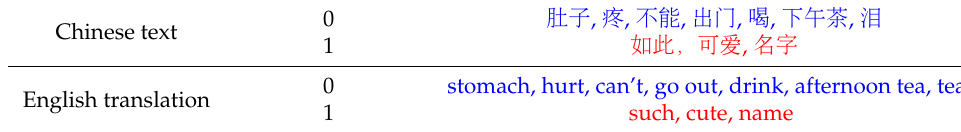
Table 10. Segments of Samples.